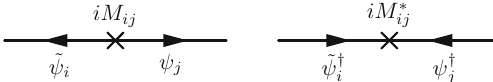
Fig. 5 may be valid with a particular R-charge arrangement, and the previous no-go statement may be